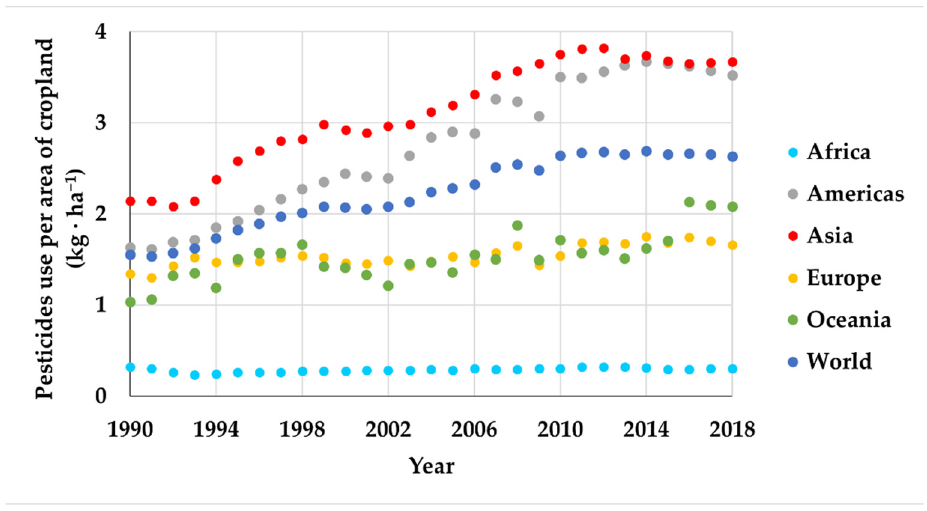
Figure 1. Pesticides use per area of cropland (data from [4]).